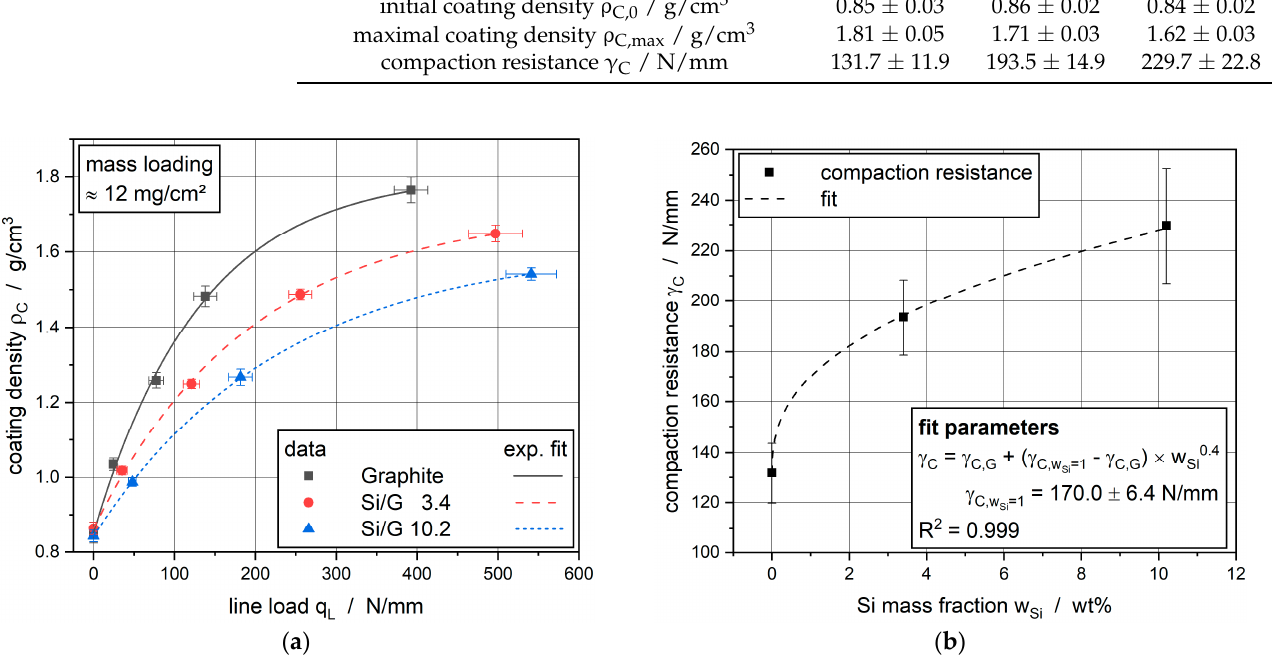
Figure 1. ( a ) Increased coating density of Si/G anodes at different line loads; ( b ) rising compaction resistance with higher silicon mass fractions. Table 3. Approximation parameters for the electrodes with different silicon mass content.